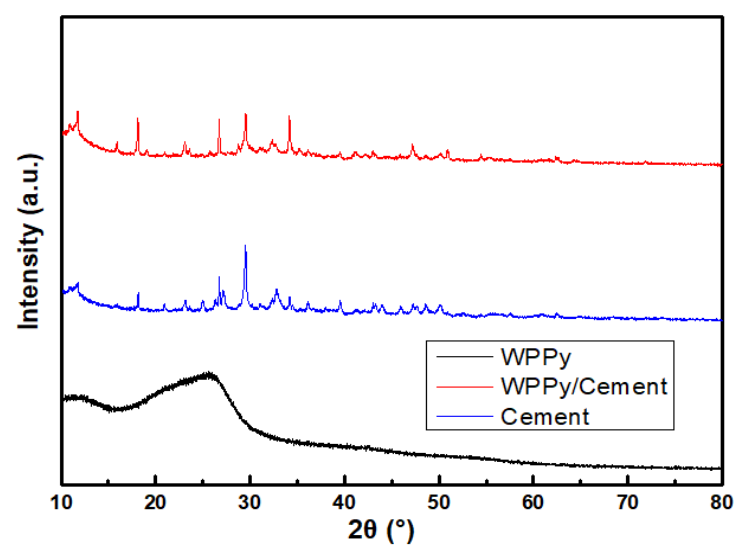
Figure 12. XRD patterns of WPPy, cement and WPPy/cement composite.